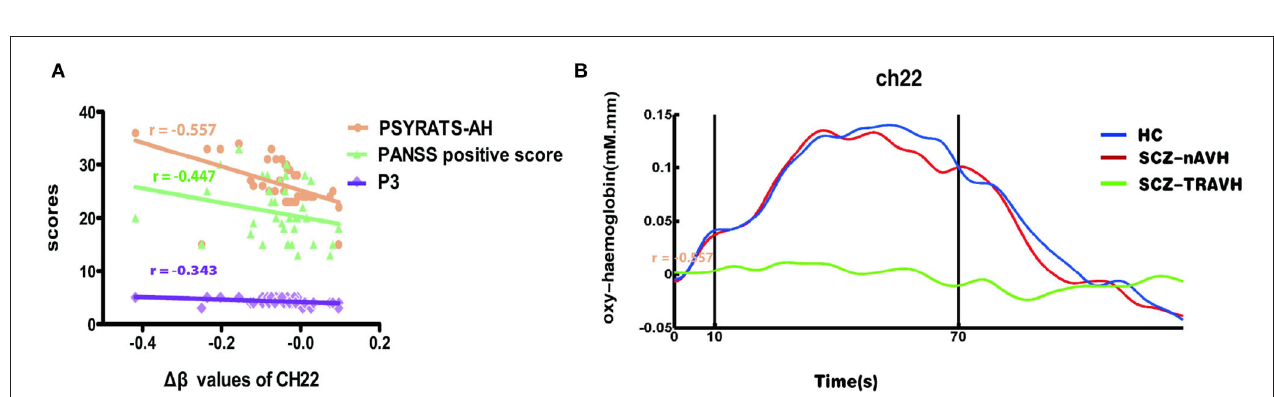
FIGURE 2 | Bonferroni corrected post hoc pairwise comparison analysis results show significant difference in mean 1 β values of oxy-hemoglobin on 24 channels (ch13–15, ch18, ch22, ch25–29, ch35–39, ch43–51). Error bars represent standard errors (all FDR-corrected * p < 0.05; ** p < 0.01; *** p < 0.001; SCZ-TRAVH and/or SCZ-nAVH vs. HC group).